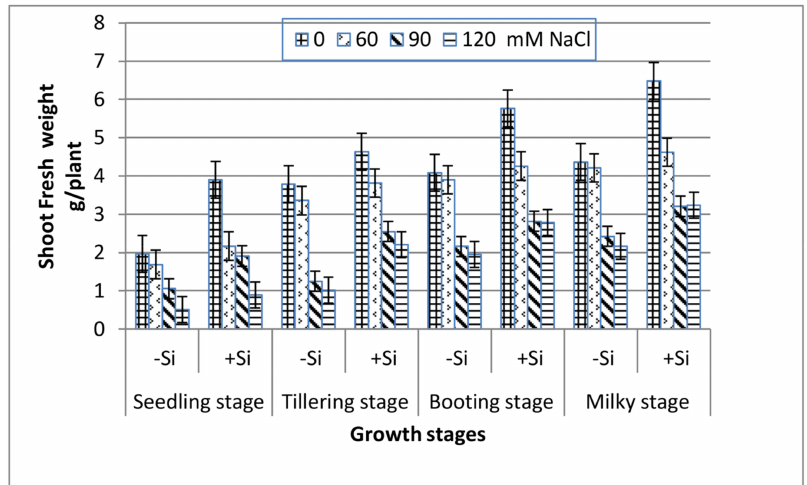
Figure 1. Effect of NaCl on the shoot fresh weight of wheat at different growth stages in the presence and absence of